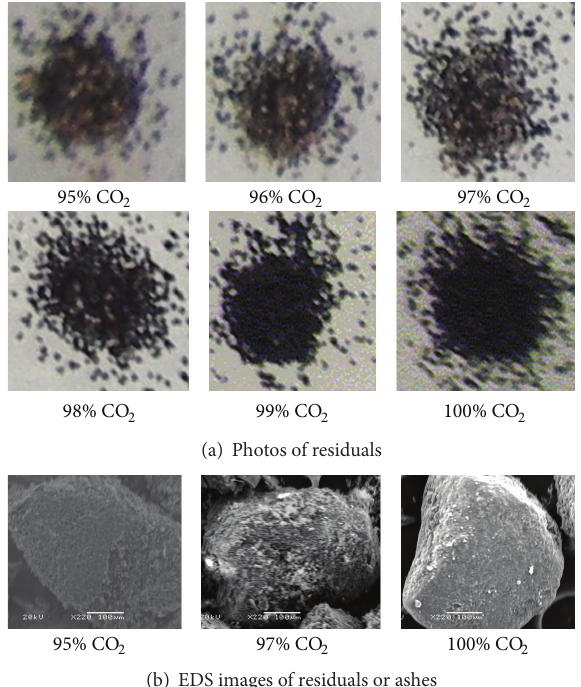
Figure 14: Photos of residuals at various CO 2 concentrations with a temperature of 1000 ∘ C.